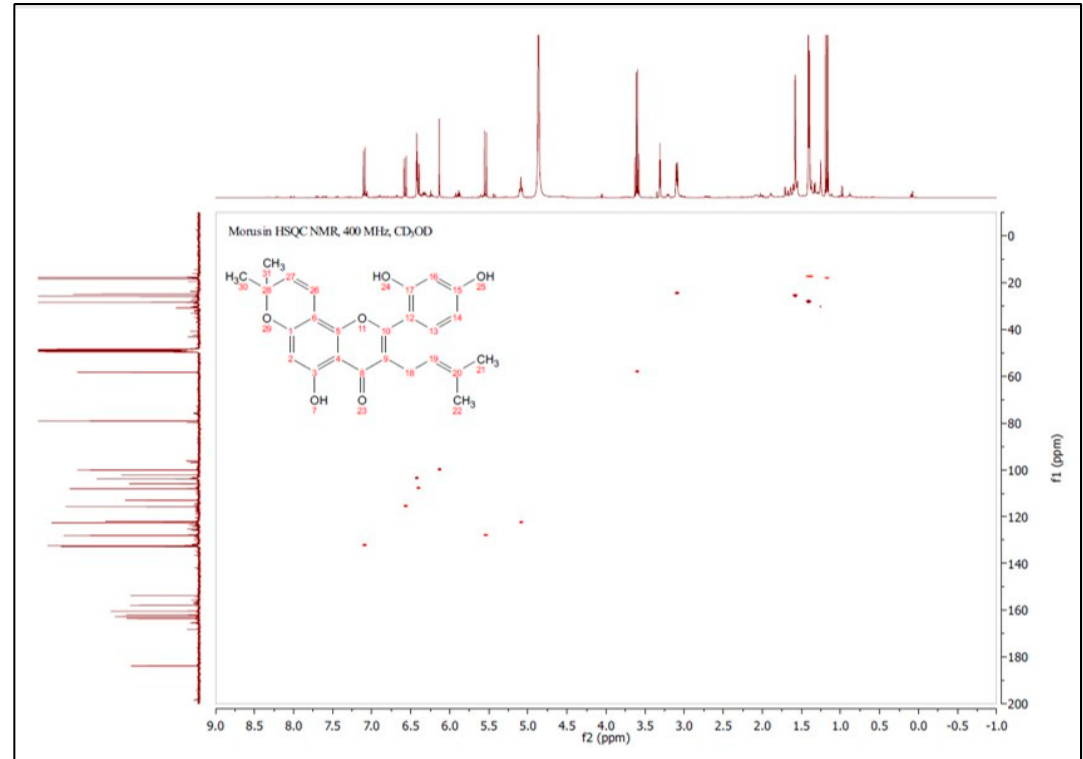
Figure A6. H-SQC NMR (CD 3 OD) spectrum of the compound Morusin.